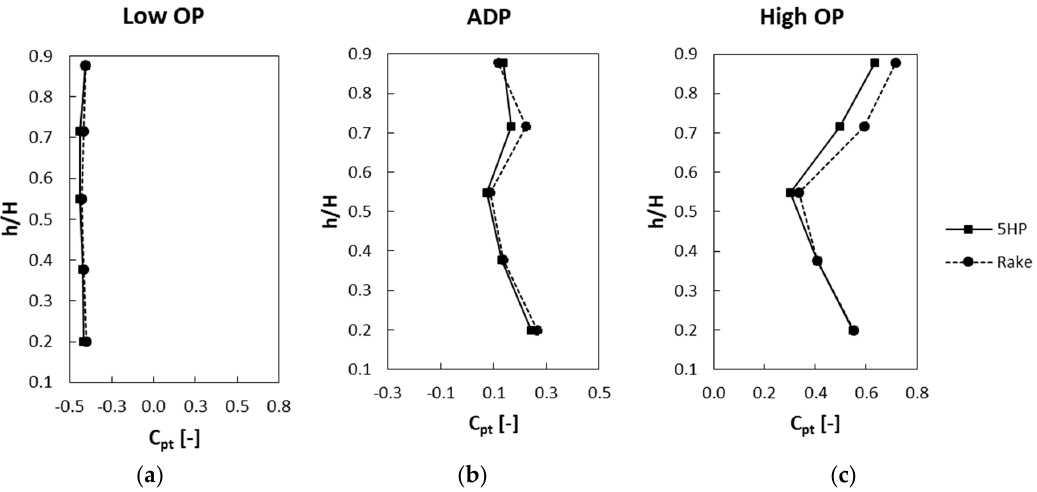
Figure 2. Comparison of the total pressure coefficient C pt between 5HP and rake for three different operating points ( a ) low OP; ( b ) ADP; and ( c ) high OP.